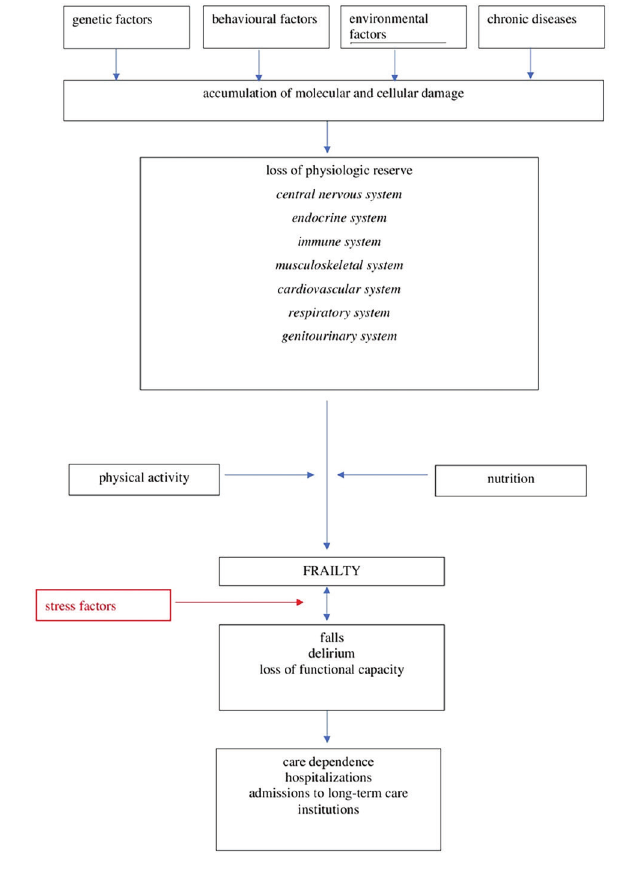
Figure 1 - Factors determining